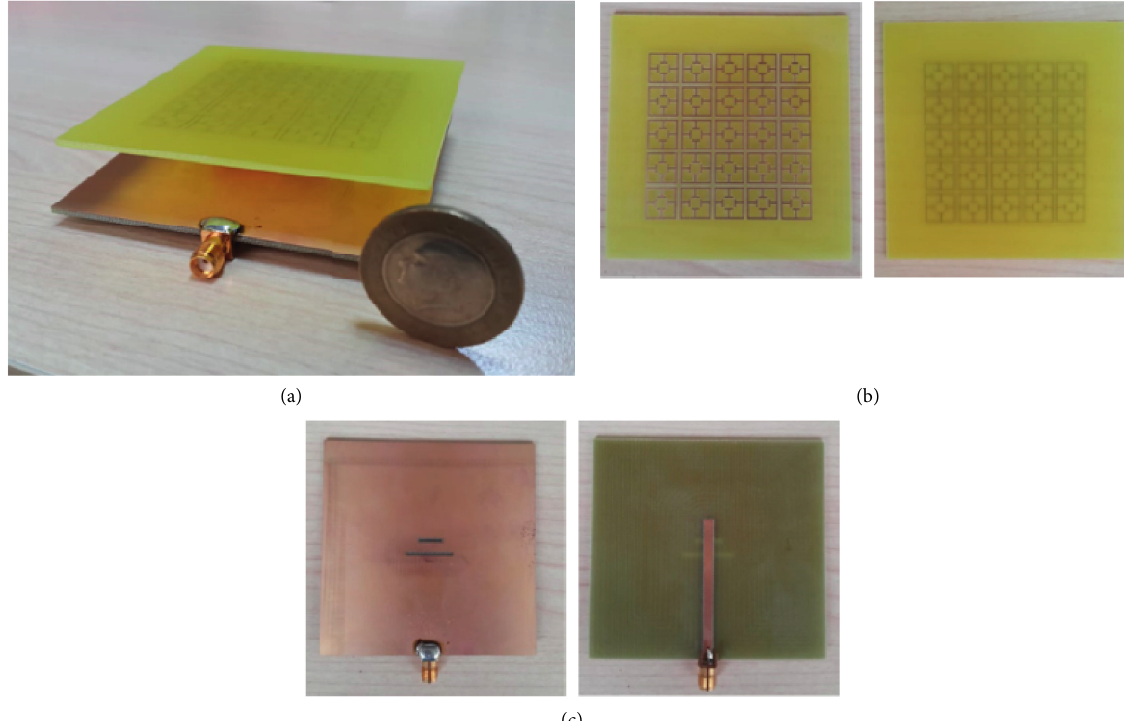
Figure 2: Photograph of the fabricated antenna with single-metasurface layer (a), both sides of the metasurface (b), and the front and back sides of the feeding structure (c).